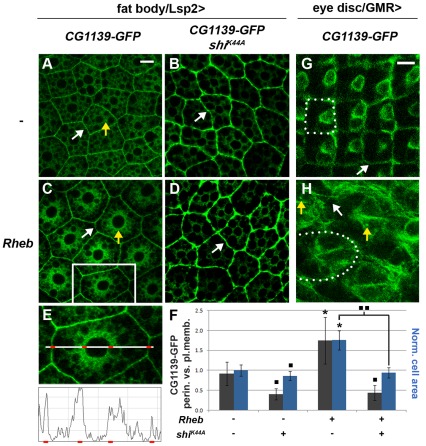
PI3K/Akt/Rheb signalling promotes shuttling of the PATs to endosomal compartments.(A, C) CG1139-GFP expressed in the larval fat body using Lsp2-GAL4 is localised to both the plasma membrane (white arrow) and also to intracellular LELs throughout the cytoplasm (yellow arrow; A). Overexpression of Rheb leads to an increase in the relative proportion of intracellular, including perinuclear, protein compared to cell surface CG1139-GFP (C). (B, D) When CG1139-GFP is co-expressed with a dominant negative version of Shibire, ShiK44A, which blocks endocytosis, in either the presence (D) or absence (B) of Rheb, the transporter is mostly located at the plasma membrane (white arrow), strongly suggesting that PATs are normally shuttled to LELs from the cell surface. (E, F) The ratio of the GFP signal intensity in a 2.25 µm perinuclear region and a 2.25 µm region at the plasma membrane (see E) was measured for genotypes in A–D (grey bars; error bars = s.d. in F). Average cell size for each genotype is also shown in F (blue bars; error bars = s.d.). n = 25; *P<0.001 (increased) and ■ P<0.001 (decreased) relative to non-Rheb/non-ShiK44A-expressing control; ■ ■ P<0.001, decreased relative to Rheb-overexpressing control. Rheb-induced changes in intracellular PATs and PAT-induced growth are entirely dependent on endocytosis. (G, H) In the larval eye imaginal disc, CG1139-GFP, expressed under GMR-GAL4 control (G), is mostly located at or near the plasma membrane, for example at the surfaces of flattened non-photoreceptor cells that surround each ommatidium (white arrows). Co-overexpression of Rheb (H) results in much larger ommatidia, with reduced staining around the ommatidial border (white arrow) and more CG1139-GFP cytoplasmic expression, including intense intracellular punctae of staining (yellow arrows), consistent with Rheb promoting endocytosis of PATs in this tissue. An outline of an individual ommatidium in G and H is marked with a dashed line. Scale bar in A is 20 µm and applies to panels A–D, scale bar in G is 5 µm and applies to panels G and H.